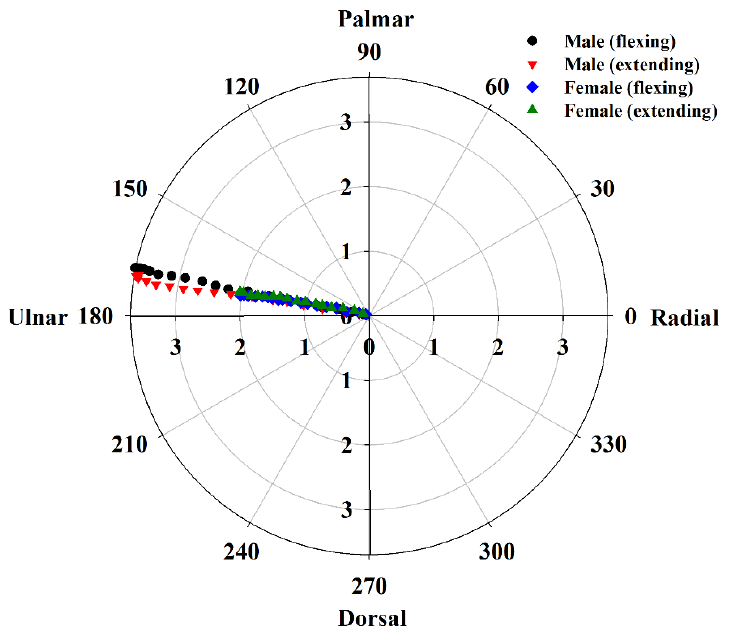
Figure 9. Averaged kinetic trajectories of the MN during finger flexion and extension in males and